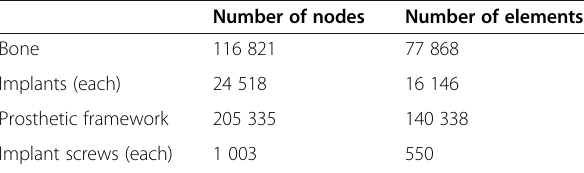
Table 4 Number of nodes and elements (C3D10) obtained for each model part